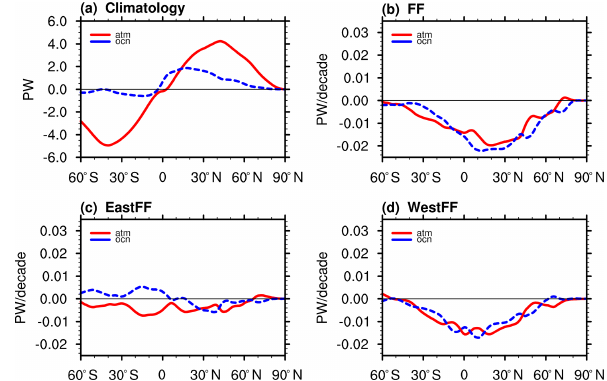
Figure 7. (a) The 40-year climatology of northward energy trans- port (petawatts; hereafter Pwatt) is calculated based on the ensemble average of ALL experiments. (b–d) The decadal trend of northward energy transport in response to FF, EastFF, and WestFF (Pwatt per decade), which is obtained by subtracting the fixed single-forcing experiments from the ALL experiment. The dashed blue lines rep- resent the oceanic energy transport; the solid red lines represent the atmospheric energy